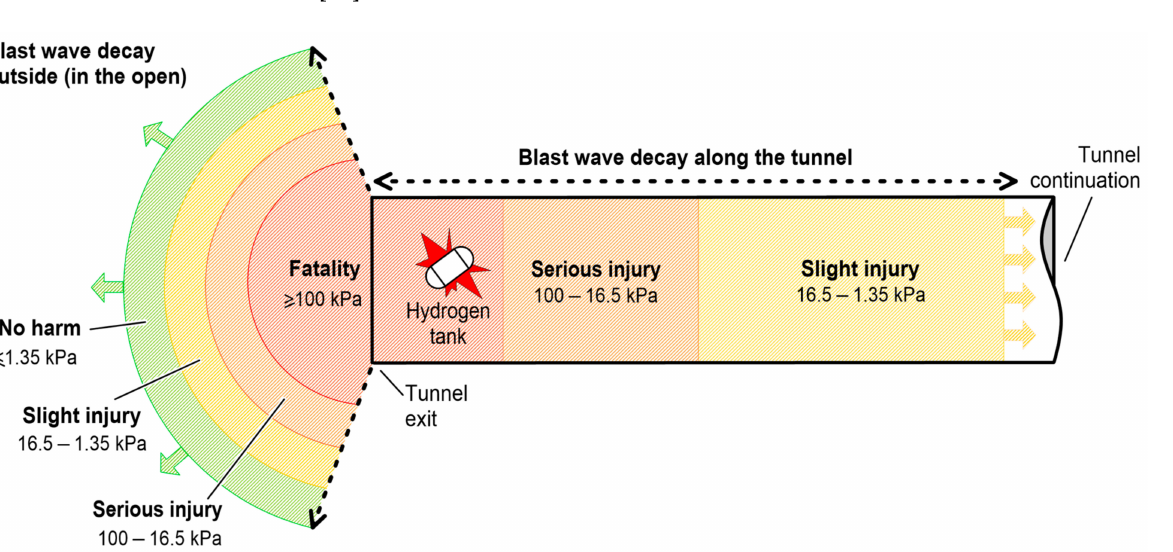
Figure 2. Schematic representation of possible overpressure threshold locations inside and outside the tunnel, corresponding to hazard